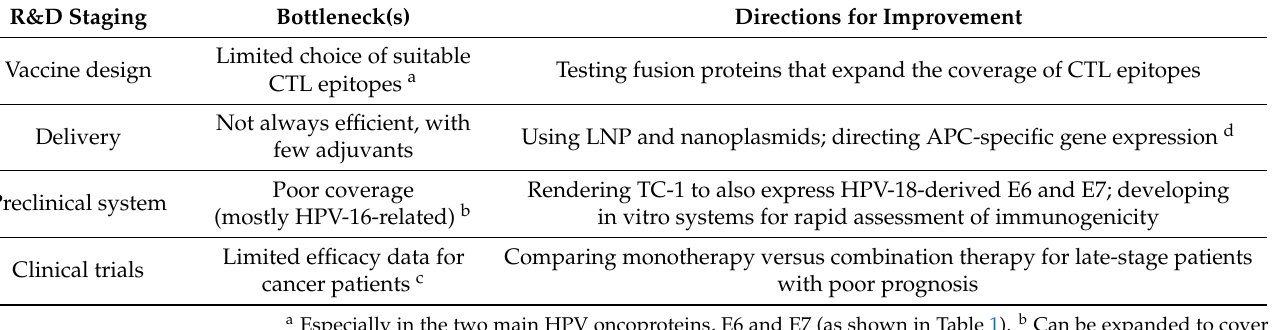
Table 3. Summary of key points drawn from past and ongoing R&D toward a DNA-based, anti-HPV